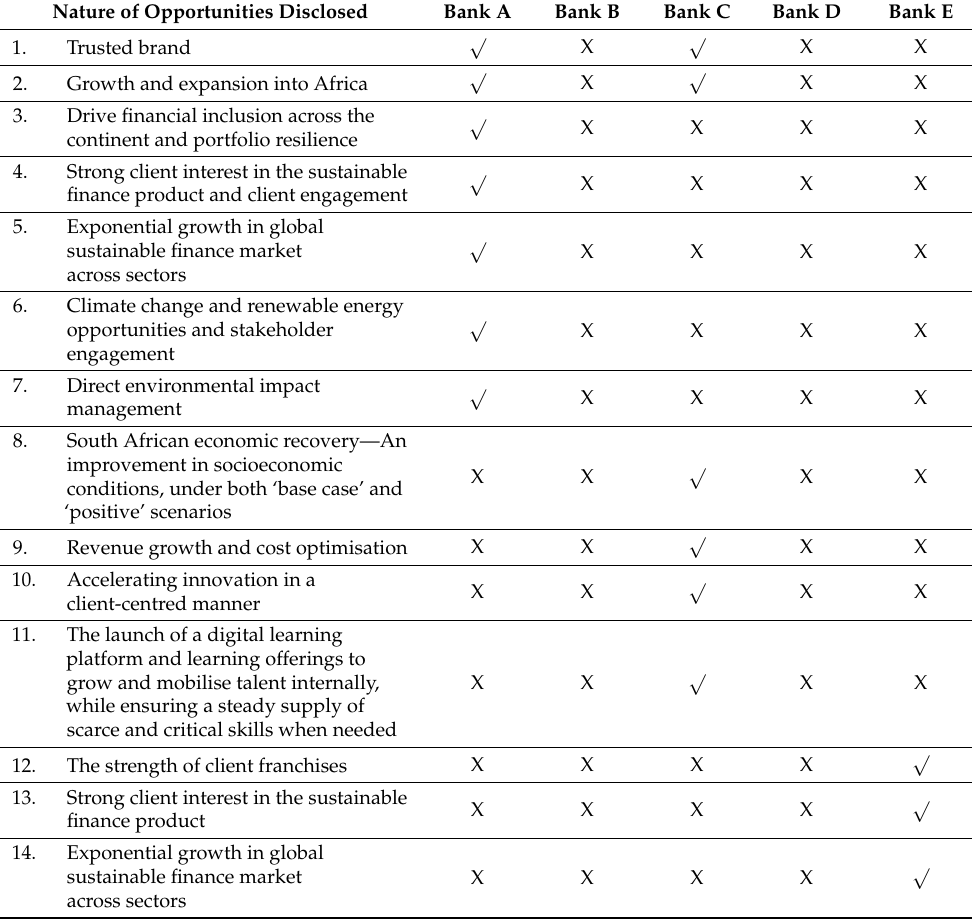
Table 4. Nature of Opportunity